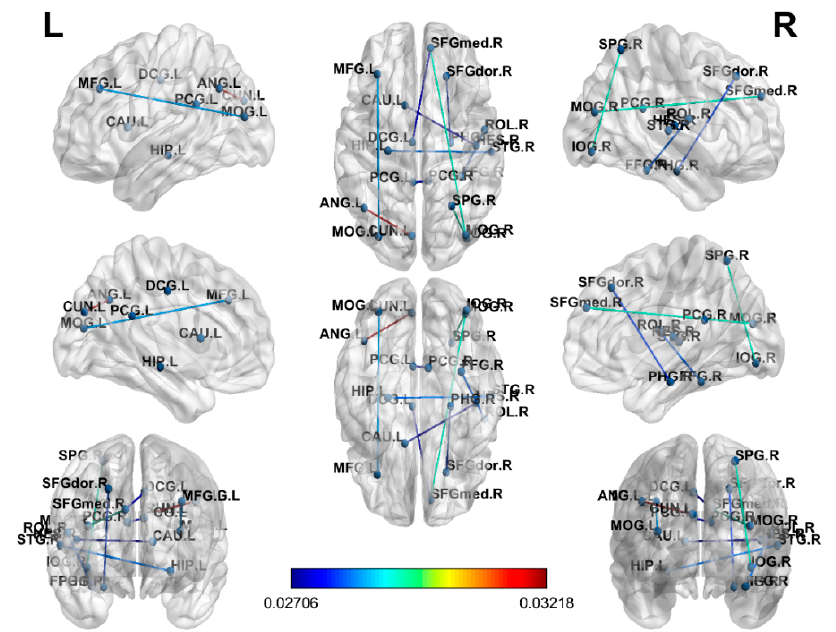
Figure 1. The weighted coefficients of the functional connections in the logistic regression (LR) model. Warmer colors represent higher absolute values of the LR coefficients. A threshold of 0.02706 was set to reduce the connections for visual presentation. Coefficients derived from the attributes of LR, representing the independent coefficient of the features in the decision function. R: right; L: left; M: middle; A: anterior; P: posterior; S: superior; I: inferior; F: frontal; T: temporal P: parietal; O: occipital; G: gyrus.